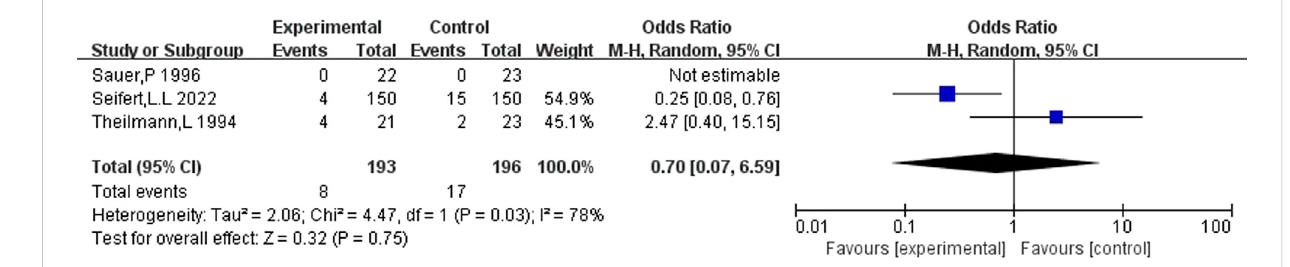
FIGURE 11 Effect of anticoagulation or antiplatelet treatment on 3 months death after TIPS.